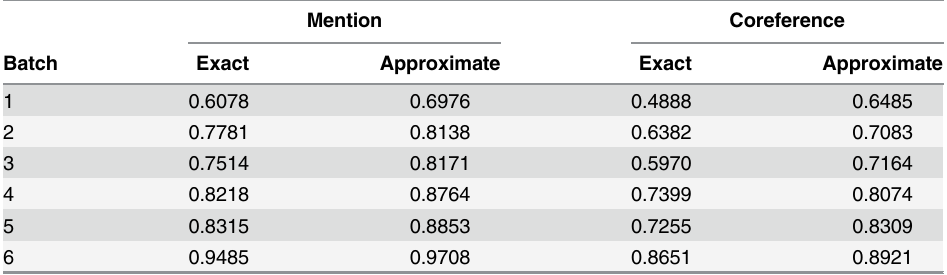
Table 5. Inter-annotator